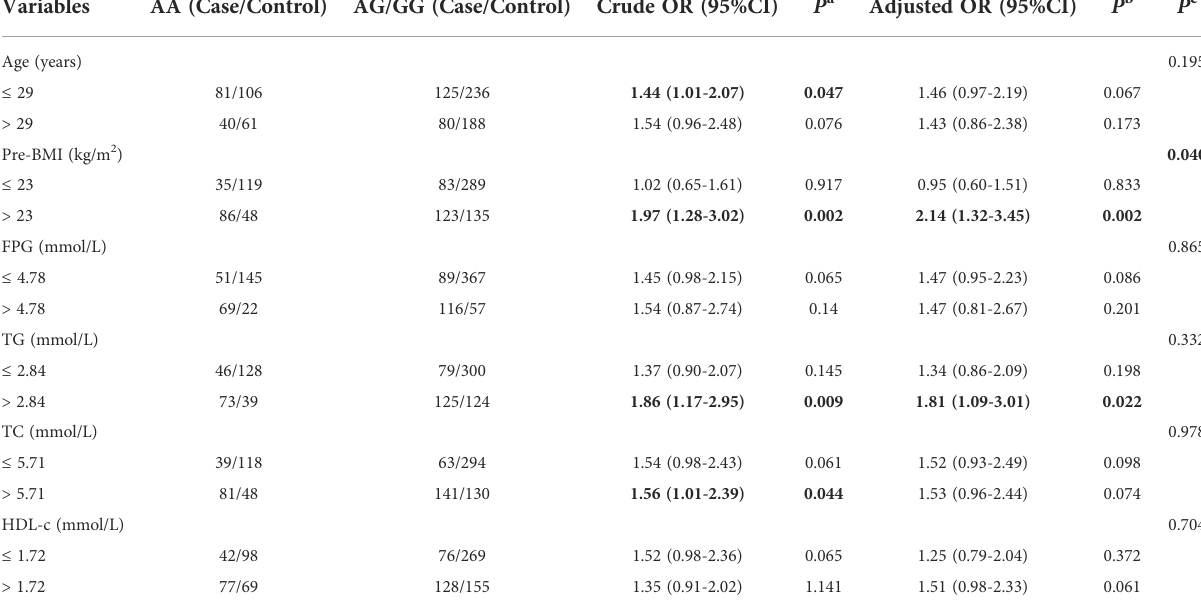
TABLE 4 Strati fi cation analysis for associations between ACE2 rs2106809 A>G and PE risk. Variables